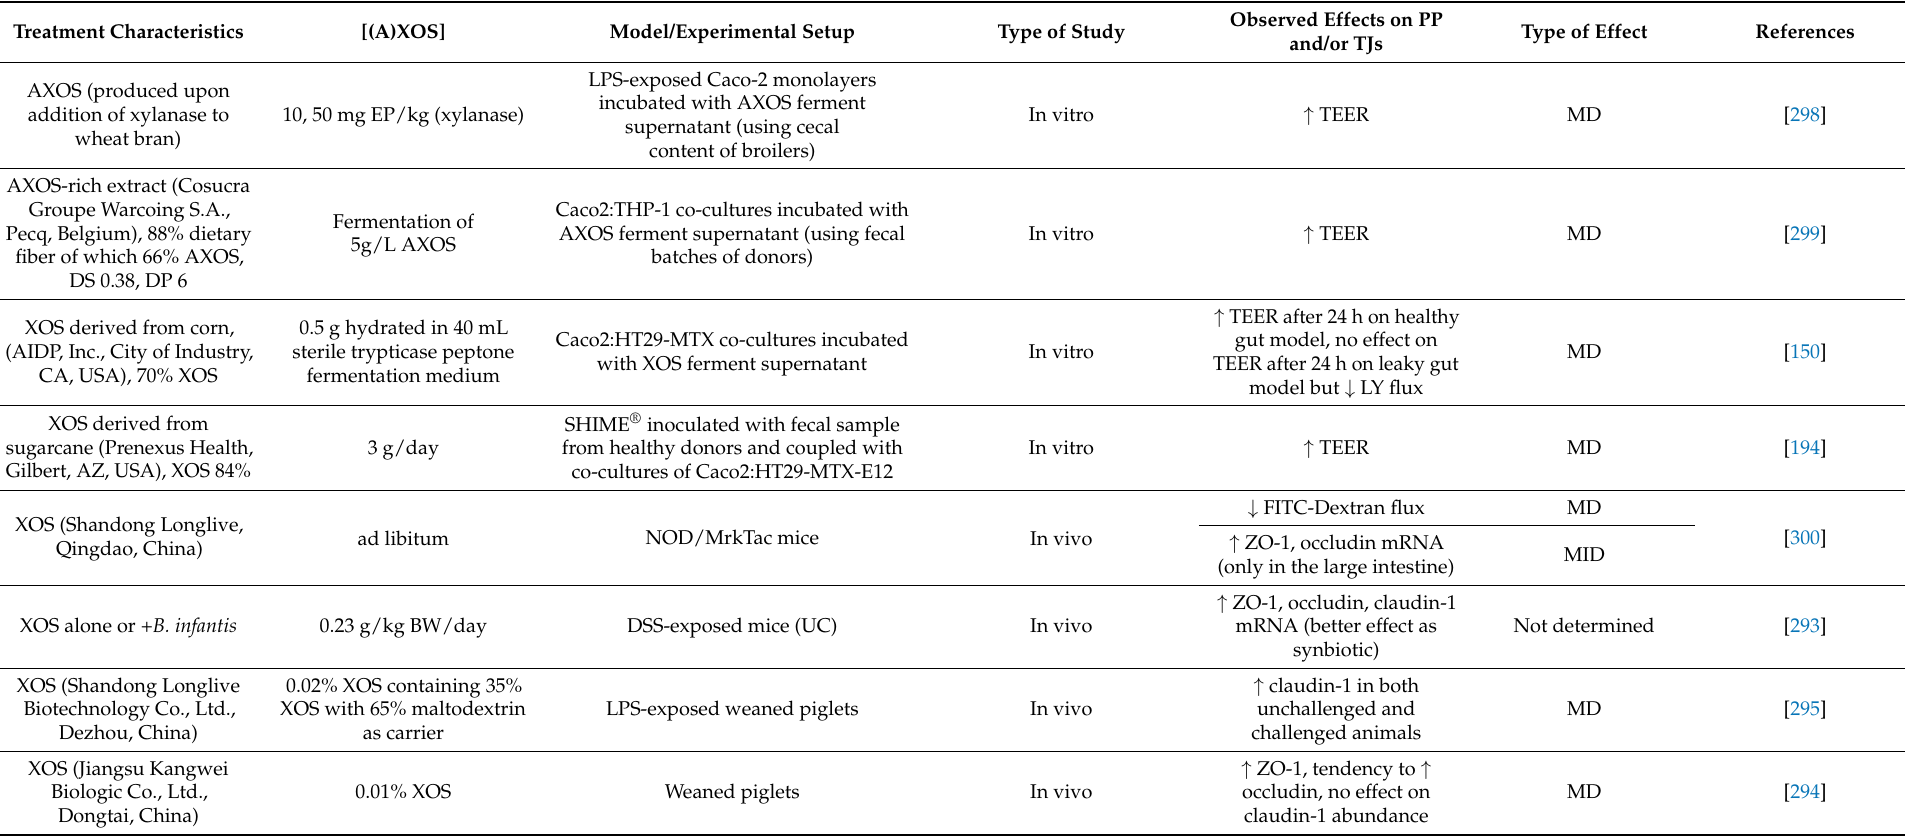
Table 6. Microbiota-dependent and independent effects of XOS and AXOS on paracellular permeability and/or